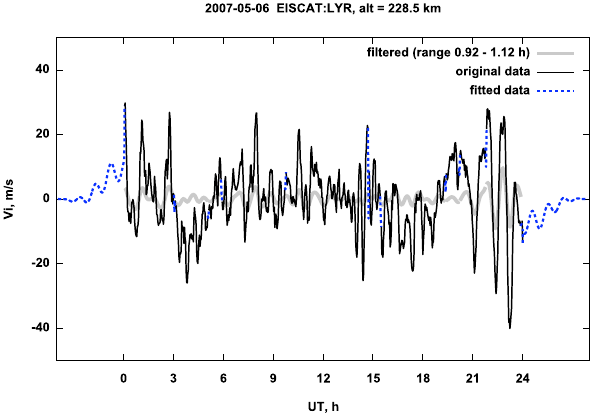
Fig. 7. Detrended line-of-sight ion velocity data from altitude 228.5km for 6 May 2007 with filled gaps and added relaxation zones and the output of filter with band-pass centred around the dominant harmonic.